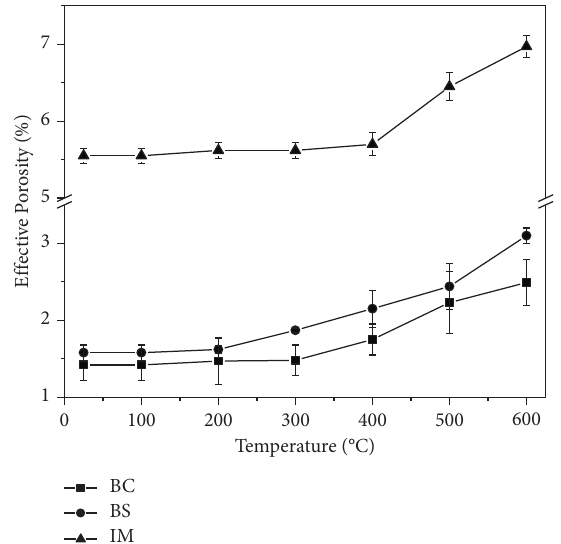
Figure 2: Increase of effective porosity as a function of the thermal treatment temperature for each